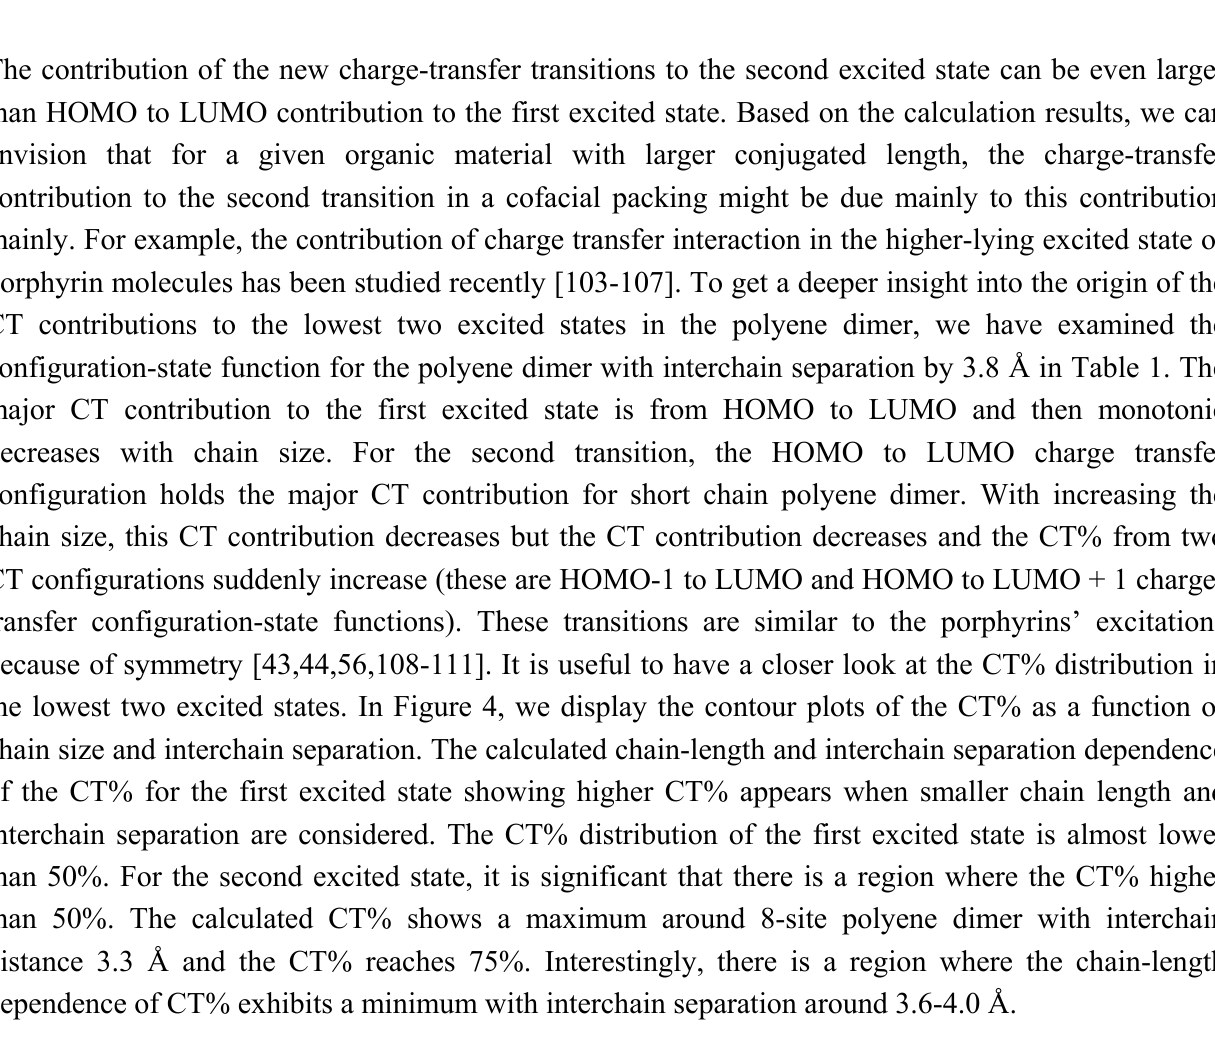
Table 1. Calculated electronic transitions and state functions for cofacial polyene dimers separated by 3.8 Å [46]. Reproduced with permission from American Chemical